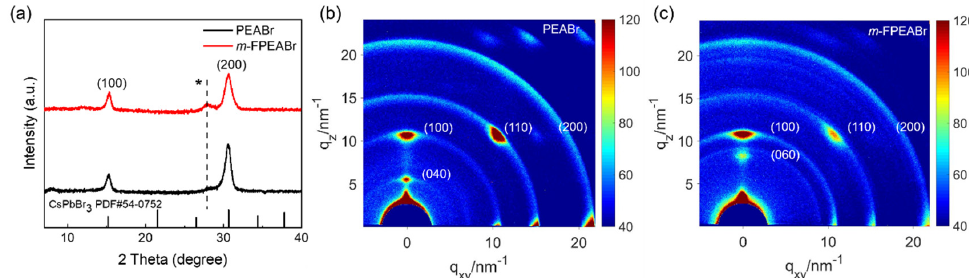
Figure 6. ( a ) XRD patterns of PEABr and m -FPEABr perovskite films. GIWAXS patterns of ( b ) PEABr and ( c ) m -FPEABr perovskite films. *: low-n phase.